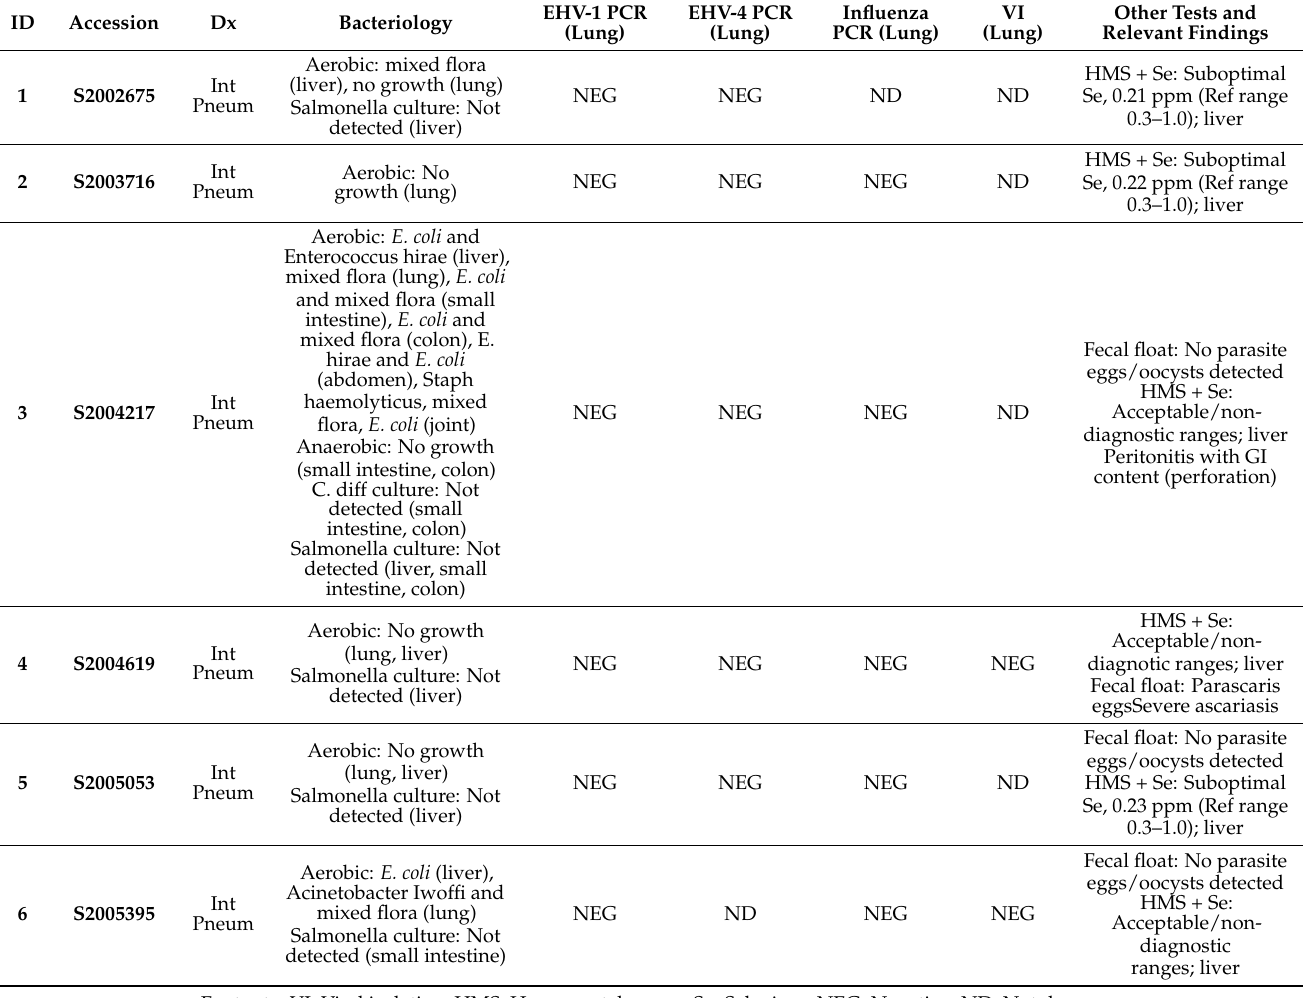
Table 3. Routine analyses results of foals with interstitial